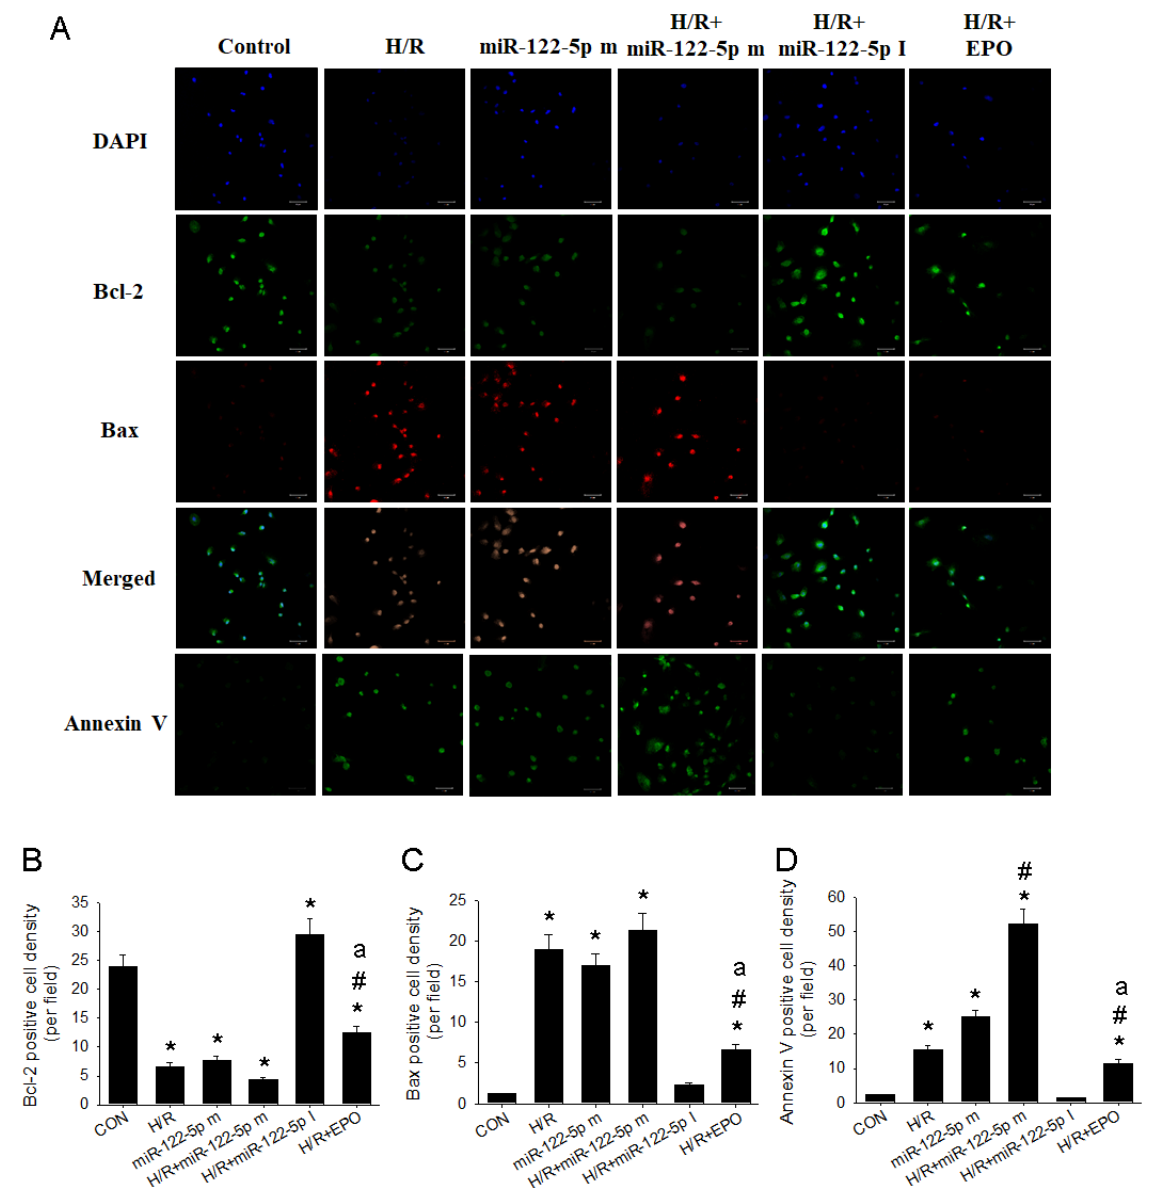
Figure 7. Effect of miR-122-5p mimics and inhibitor on H/R-induced Bcl-2, Bax, and apoptosis formation in the NRK-52E cells. ( A ): The immunofluorescence graphs of DAPI (blue), Bcl-2 (green), Bax (red), merged image, and Annexin V (green) in response to Scheme 2 positive cell density; ( B ): Bcl-2 positive cell density, ( C ): Bax positive cell density and ( D ): Annexin V positive cell density. Data are expressed as mean ± SEM (n = 3). * p < 0.05 compared with CON group. DAPI, 4’,6-diamidino-2-phenylindole; EPO, erythropoietin; H/R, hypoxia/reoxygenation; SEM, standard error mean. # p < 0.05 compared with H/R group. a p < 0.05 vs. H/R+miR-122-5p m group.